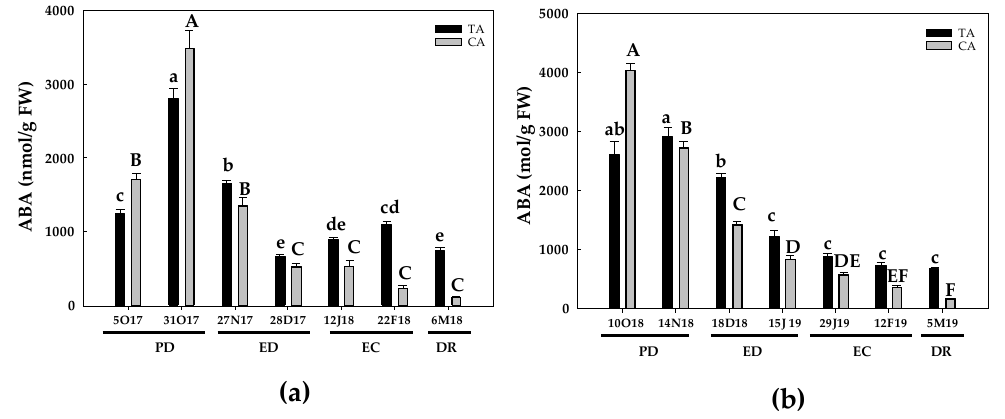
Figure 18. Evolution of abscisic acid (ABA) content in flower buds of peach ‘GEM020’ cultivated in a cold area during the dormancy cycle on two seasons. ( a ): season 1 (2017–2018); ( b ): season 2 (2018–2019). Data represent the mean ± SE, n = 5. Different letters (lowercase and uppercase for the samples of the temperate (TA) and the cold area (CA), respectively) indicate significant differences according to Tukey’s multiple test ( p ≤ 0.05). PD: paradormancy; ED: endodormancy; EC: ecodormancy; DR: dormancy release. FW: fresh weight. The chill units accumulated at the different times and locations are shown in Supplemental file 1.